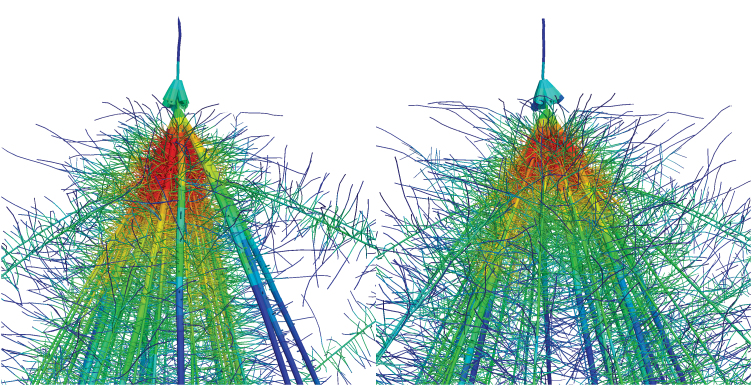
Close-up views of SimRoot models parameterized as the average of the Old (left) and Modern (right) Era period phenotypes. The modern Era root system is marginally more shallow and has fewer nodal roots. (This figure is available in colour at JXB online.)